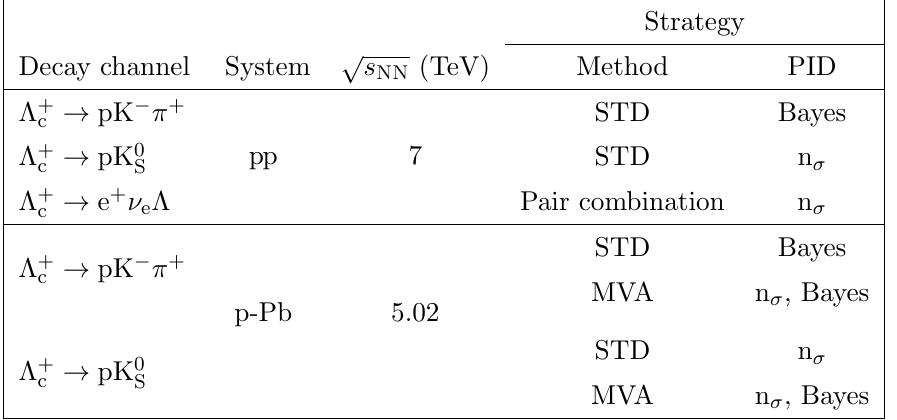
Table 1 . (cid:3) c decay channels studied and analysis methods presented in this